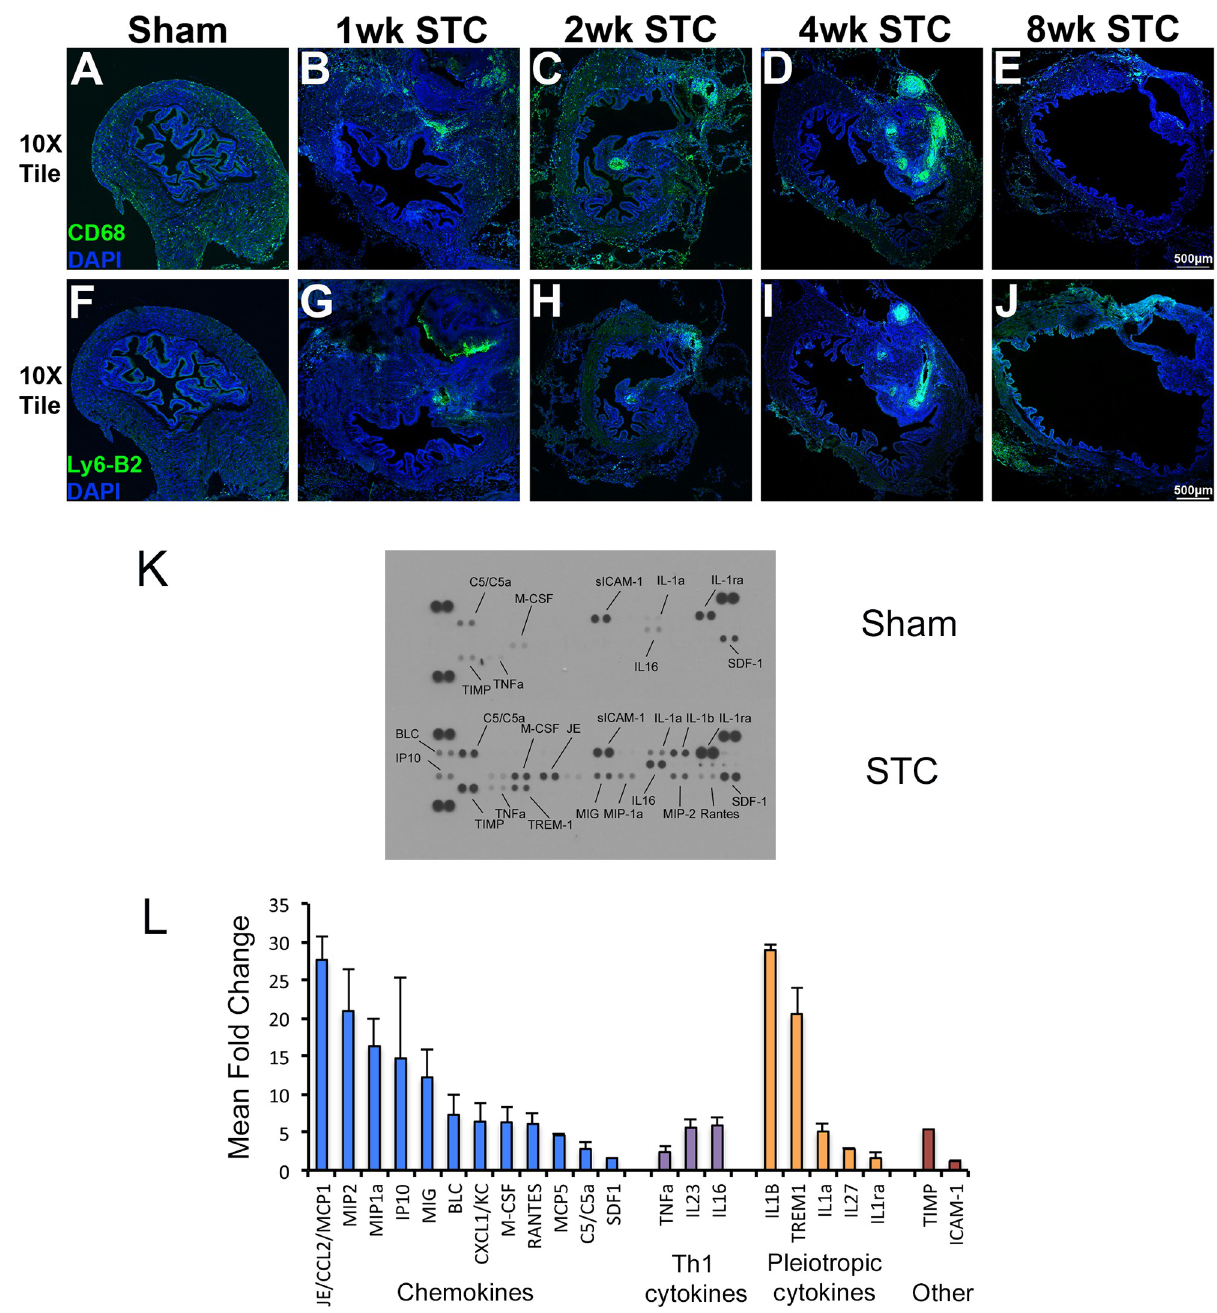
Fig 9. Inflammatory cell invasion into the regenerating portion of the bladder is characterized by a pro-inflammatory cytokine response. Tiled confocal images of bladder sections stained with antibodies to CD68 (A-E) and Ly-6B.2 (F-J). Anti-CD68 marks infiltrating macrophages and anti-Ly- 6B.2 marks infiltrating neutrophils. Leftmost panels (A, F) are sham bladders. Other panels are from STC surgery and are labeled as above. (K) Representative images of cytokine arrays interrogated with protein isolated from sham surgery bladders (top) and STC surgery bladders (bottom) one week after surgery. Cytokines of interest are indicated next to each set of duplicate spots. (L) Densitometric quantification of images similar to and including those shown in (K). Only bars that demonstrated statistically significant changes (P < 0.05) are shown. Bars are grouped by color: blue bars represent chemokines, purple bars represent Th1 cytokines, yellow bars represent pleiotropic cytokines and red bars represent TIMP and ICAM-1.